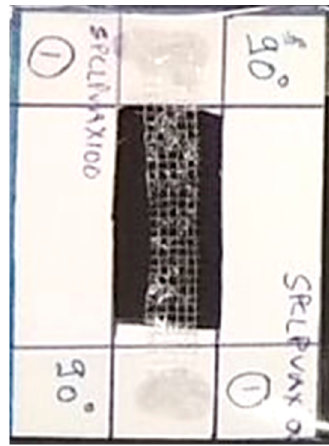
Figure 5. Representative digital photograph of the sample mounted on a trimmed cardboard sheet.